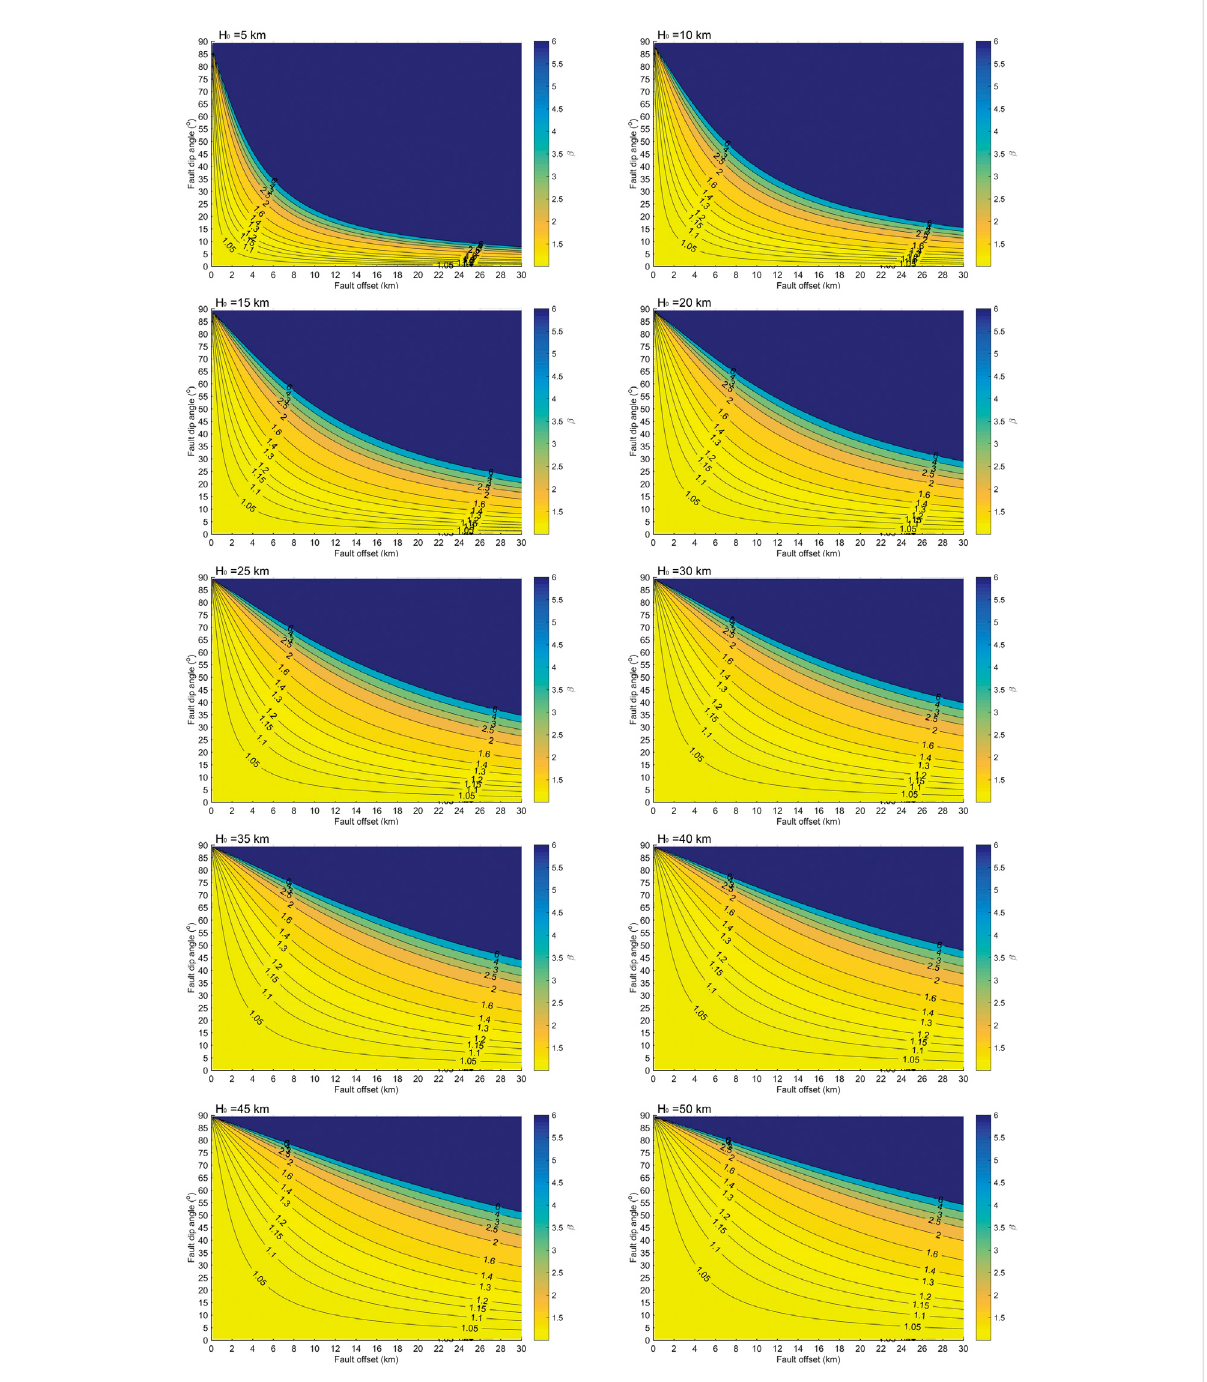
FIGURE 5 Comparisonof β contour-plotsintheparameterdomainspace(dip-offset)areshownatH 0 =5 km,10 km,15 km,20 km,25 km,30 km,35 km, 40 km, 45 km, and 50